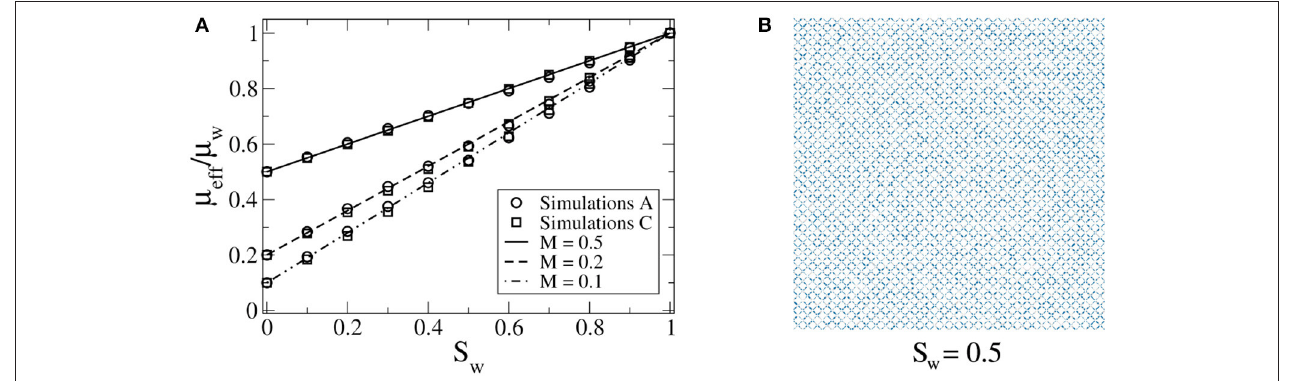
FIGURE 1 | (A) Plot of ( µ eff /µ w ) α obtained from 2D network simulations (symbols) with small bubbles (A) or with many interfaces (C). Results are consistent with Equation (14) (straight lines) with α 1. A steady-state snapshot for model C is shown in (B) , where gray and blue are the wetting and non-wetting fluids respectively. = Here the wetting fluid is more viscous and the results for less viscous wetting fluid are the same for the network model due to the symmetry in the interface rules and the lack of film flow mechanism in the model.